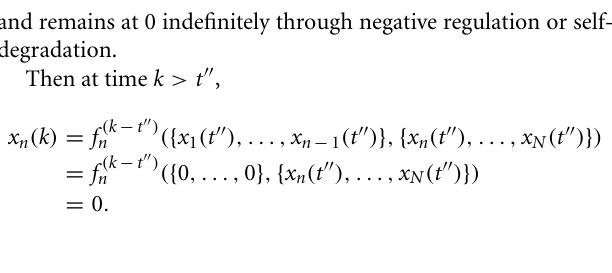
Protein lifetime is set at t d = 1. All negative regulations are assigned a common coefficient a ij = a r = − 1. All positive regulations are assigned a ij = a g . (A) Shows the attractor set associated with a g = 1. (B) Shows the attractor set associated with a g = 2. (C) Shows the attractor set associated with a g = 3. For each panel, the rows are the attractors, which are all fixed points, and columns 2 through 12 indicate whether a protein is on (1) or off (0) in the attractor. Column 1 lists the basin size of each